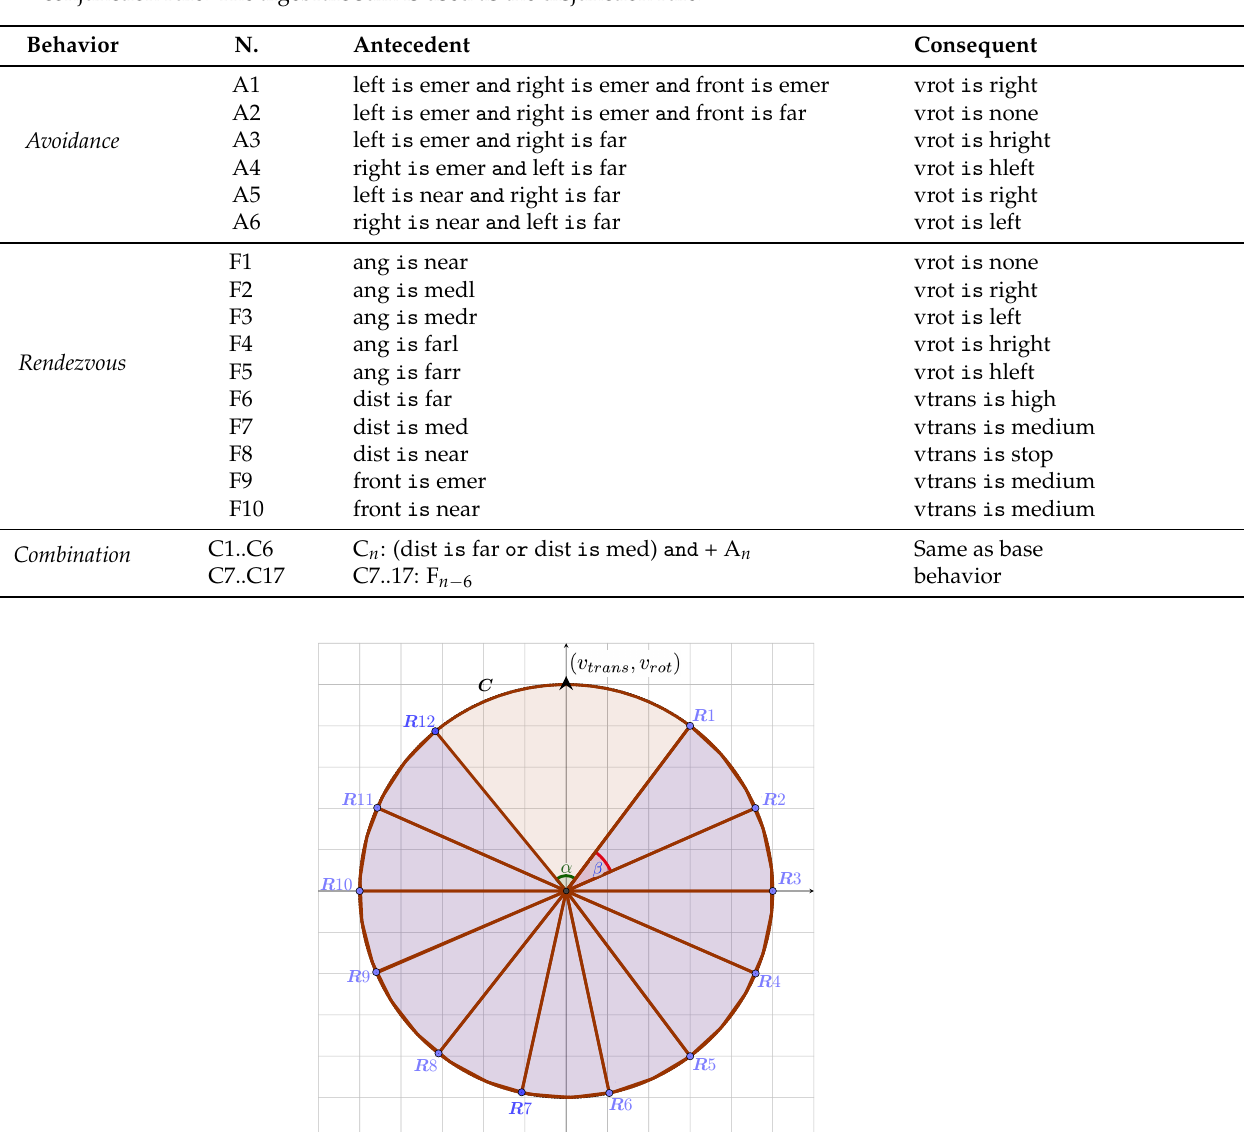
Table 1. Rules of each fuzzy microscopic behavior along with the corresponding weights. The combination of the microscopic avoidance system with the microscopic rendezvous system is also shown. The algebraic product is used as the conjunction rule. The algebraic sum is used as the disjunction rule.